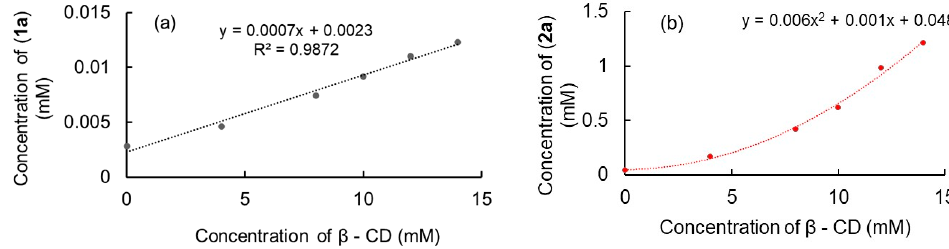
Figure 8. Phase solubility diagrams of ( 1 ) and β -CD system ( a ) and ( 2 ) and β -CD system ( b ). Solution EPR Spectra